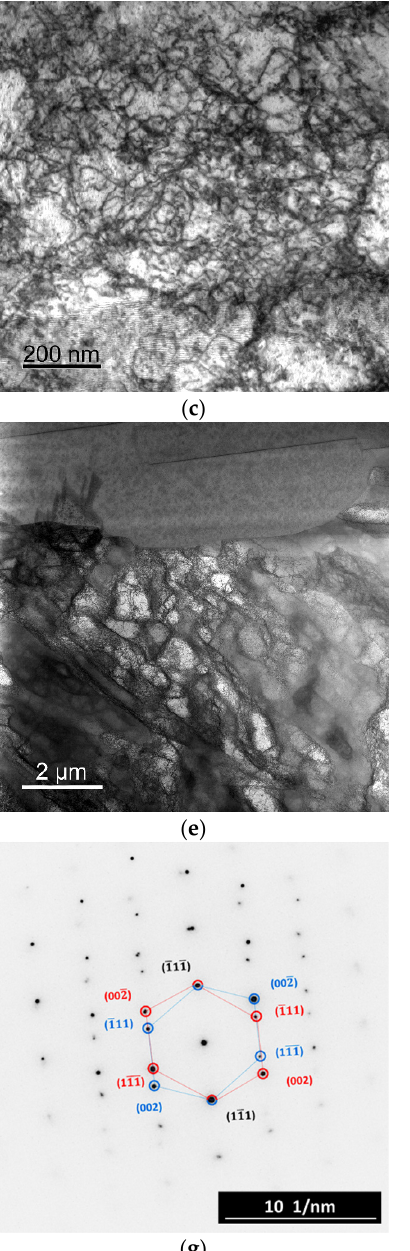
Figure 5. TEM images depicting characteristic structural features for Cu lamellas of swaged laminate ( a , b ); HT1 laminate ( c , d ); HT2 laminate ( e ). Twin within structure of HT2 laminate ( f ) and its diffraction pattern ( g ).